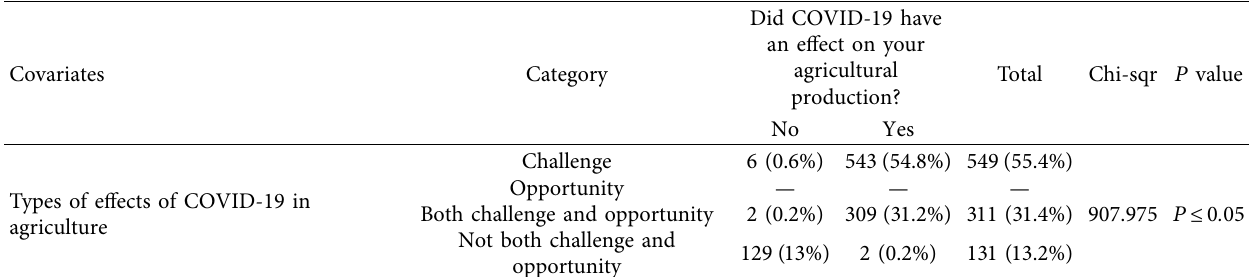
Table 2: Nature of the effect of COVID-19 on agricultural